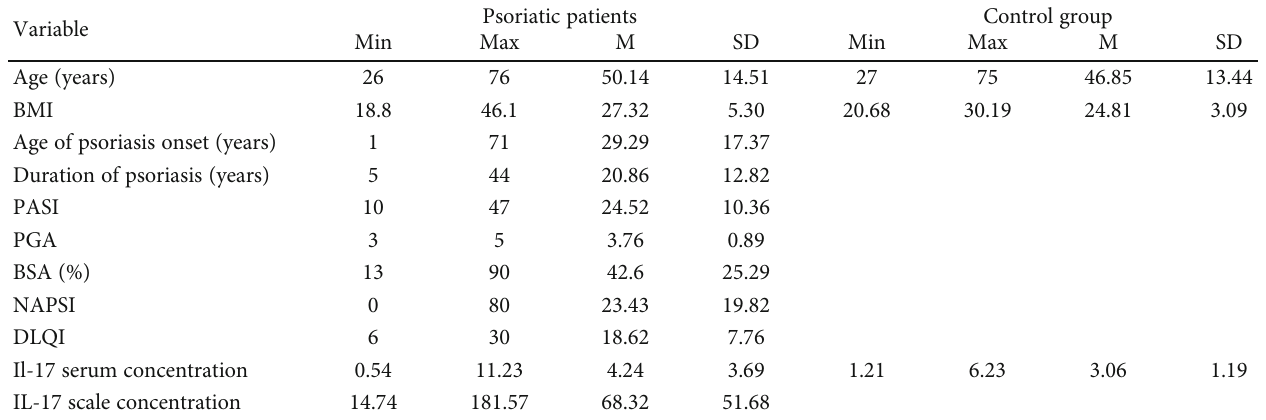
Table 1: Characteristics of studied groups.